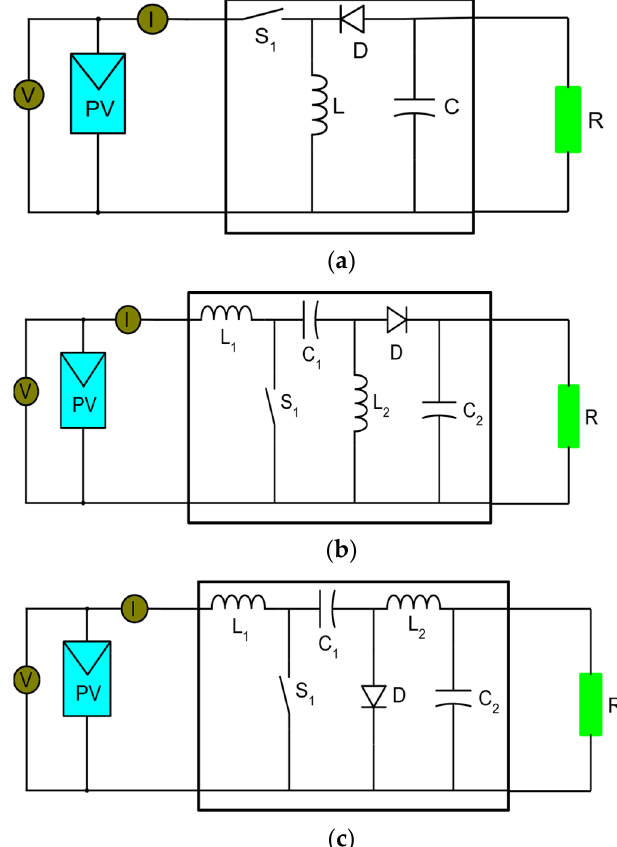
Figure 17. Derived DC–DC converters: ( a ) Buck-boost; ( b ) SEPIC; ( c ) Cuk. Source [60], own